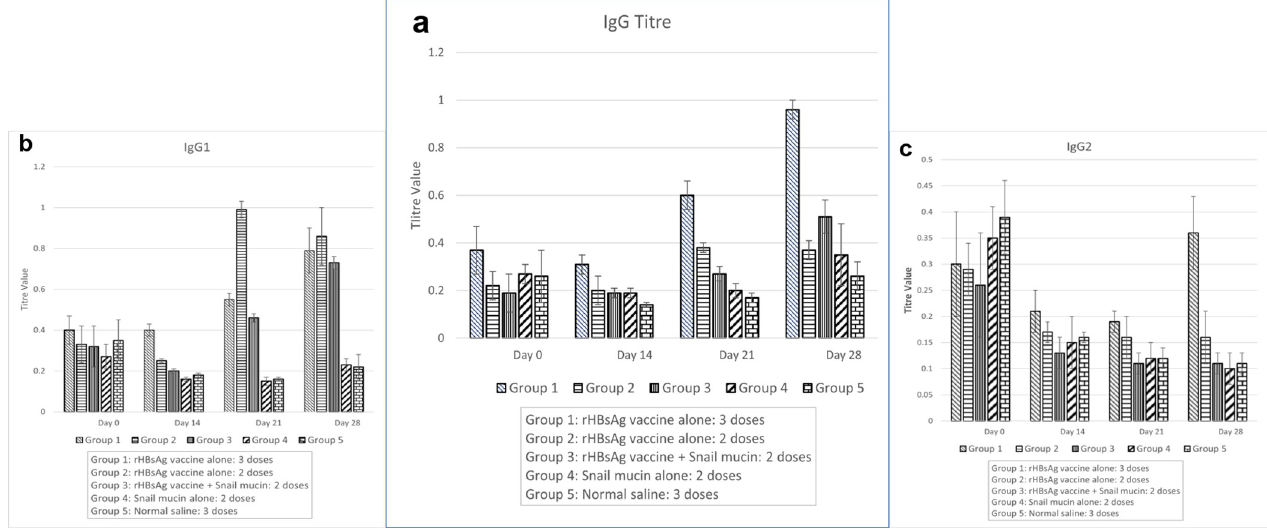
Fig 4. Effect of snail mucin-adjuvanted rHBsAg vaccine on IgG, IgG1 and IgG2a titre of experimental mice. The figure shows the IgG titres (a), IgG1 titre (b) and IgG2a titre (c) across the experimental groups obtain from an iELISA experiment. Results are expressed as mean ± SD (n = 5) with a confidence interval of